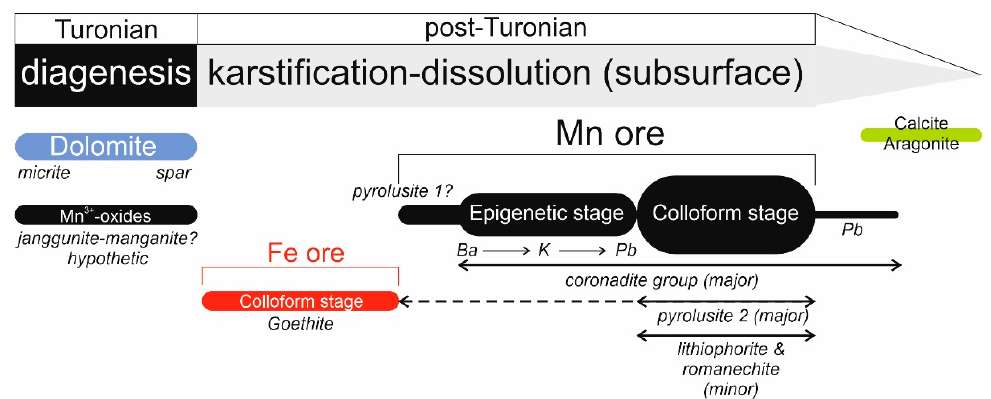
Figure 2. Simplified and modified paragenetic sequence. The position of the Fe mineralization prior to the Mn oxide is illustrated. Adapted from [12].